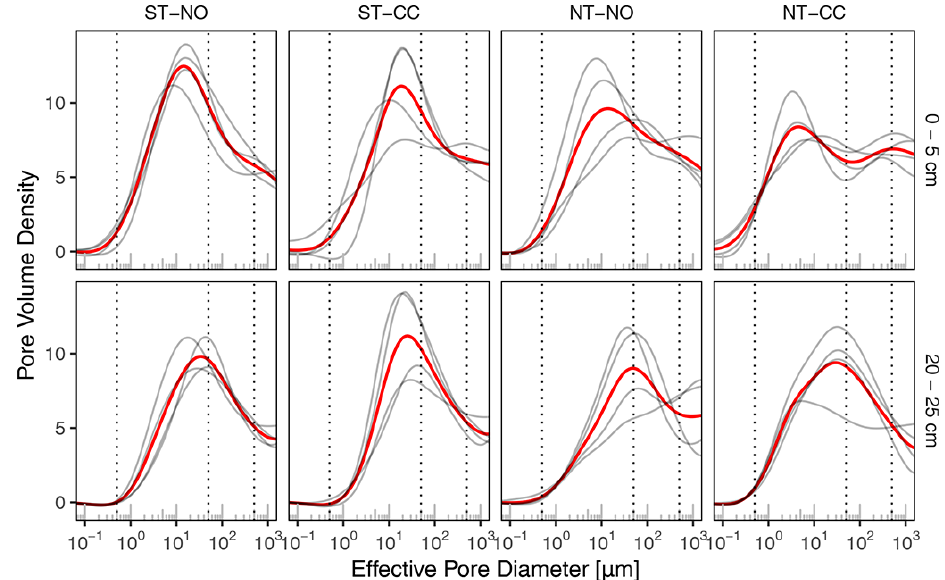
Figure A3. Effective pore size distribution. Gray curves are individual soil core measurements, and thick red curves are the treatment means. Vertical dotted lines indicate pore diameter sizes of 0.5, 50, and 500µm.